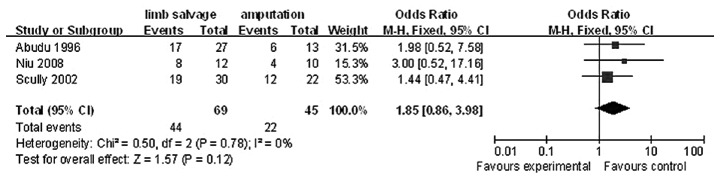
Forest plot of comparison: 5-year overall survival of limb salvage vs. amputation for the treatment of osteosarcoma in patients with pathological fracture.